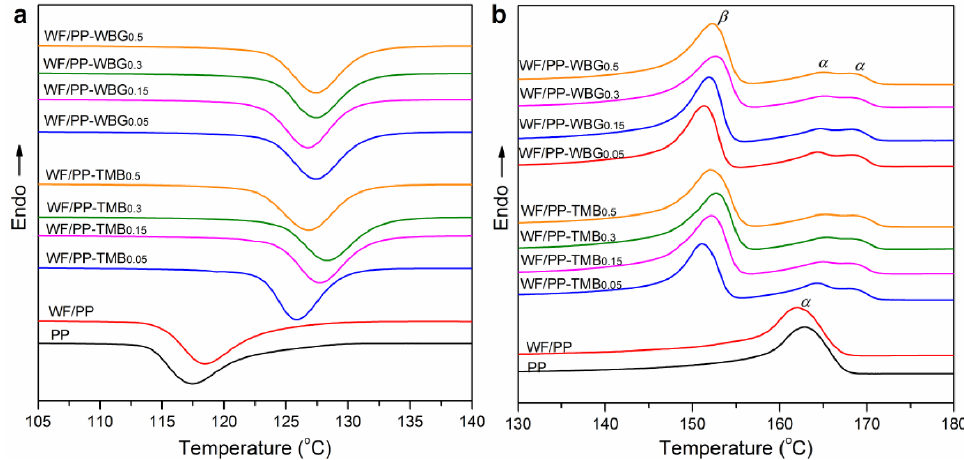
Figure 5. DSC ( a ) crystallization and ( b ) subsequent melting thermograms of pure PP, WF/PP, WF/PP-TMB and WF/PP-WBG containing varying concentrations of TMB5 or WBG II at cooling and melting rate of 10 °C/min.